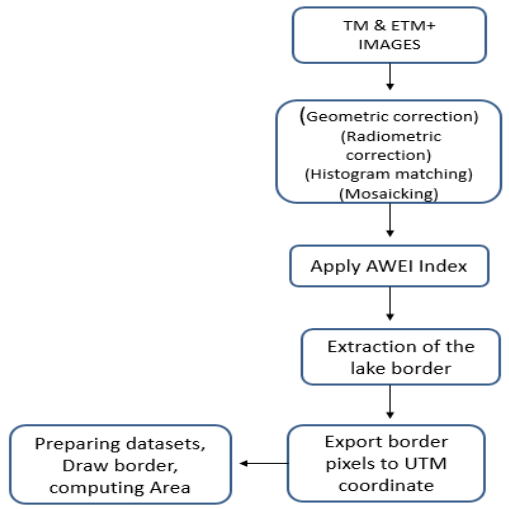
Fig. 1. Water level variations of the Lake Urmiah.